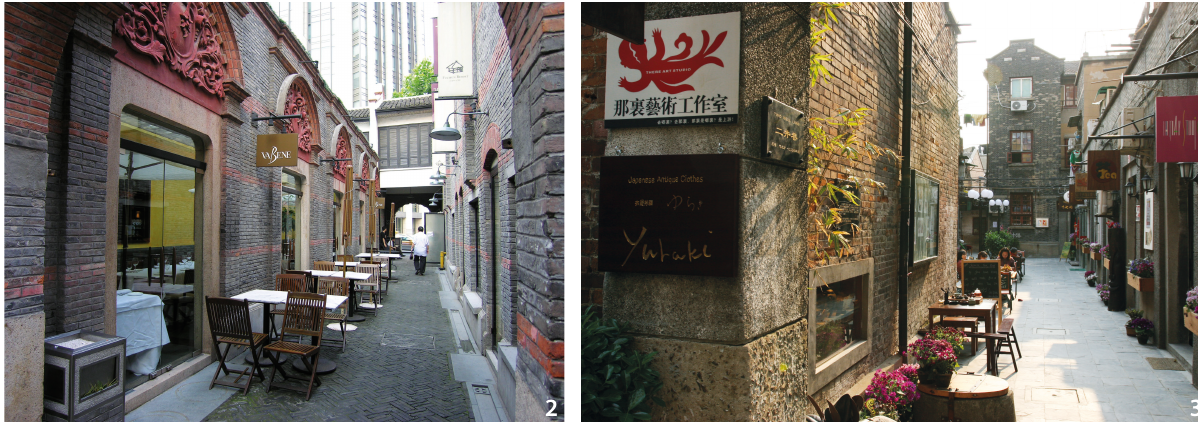
Figure 2 View of the renovated lilong houses in Xintiandi (Source: Institute of Shanghai Architectural Design and Research Co., Ltd). Figure 3 Lilong houses in Tianzi-fang, Taikang Road (Source: Institute of Shanghai Architectural Design and Research Co.,